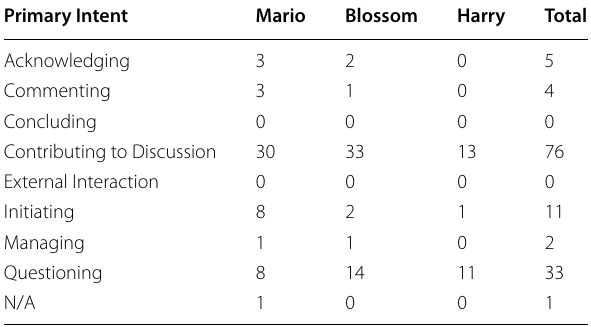
Table 6 Frequency counts of Primary Intents for Mario,